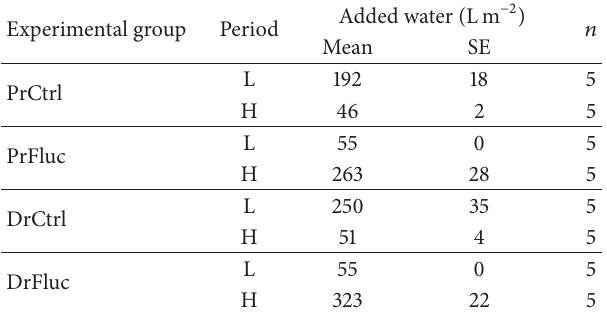
Table 2: Spring water volumes (transformed per m 2 ) added to each experimental group during the low water table (L) and high water table (H) periods within the five-month experiment. Experimental group